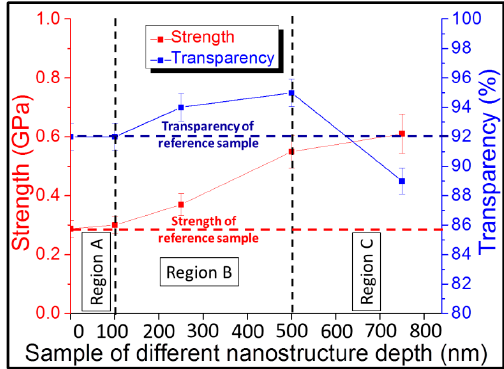
Figure 7. Strengths and transparencies for nanostructured samples with different depths; Region A shows the range of nanostructure depths for which there is almost no change in strength and transparency; Region B is the optimum range for both strength and transparency, where both strength and transparency are improved relative to the plain borosilicate glass; and Region C shows the range of nanostructure depths at which strength is improved and saturated, but transparency is reduced due to scattering.